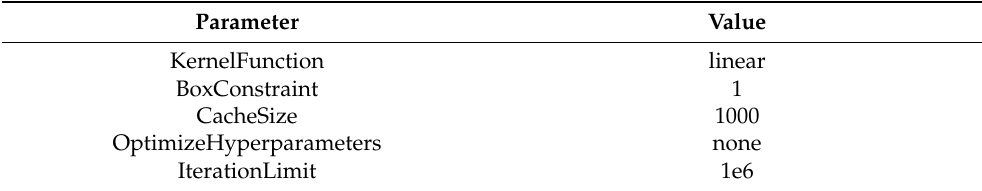
Table 3. Some typical parameters used in the training